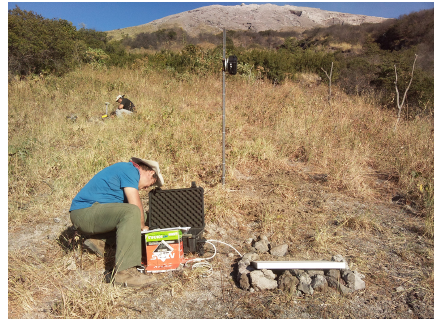
Figure A1. Ranchito multiparametric station (RANC). Seismic sta- tion in the foreground; the radiometer is installed on the pole in the image center; the GPS station is visible a few meters further up.